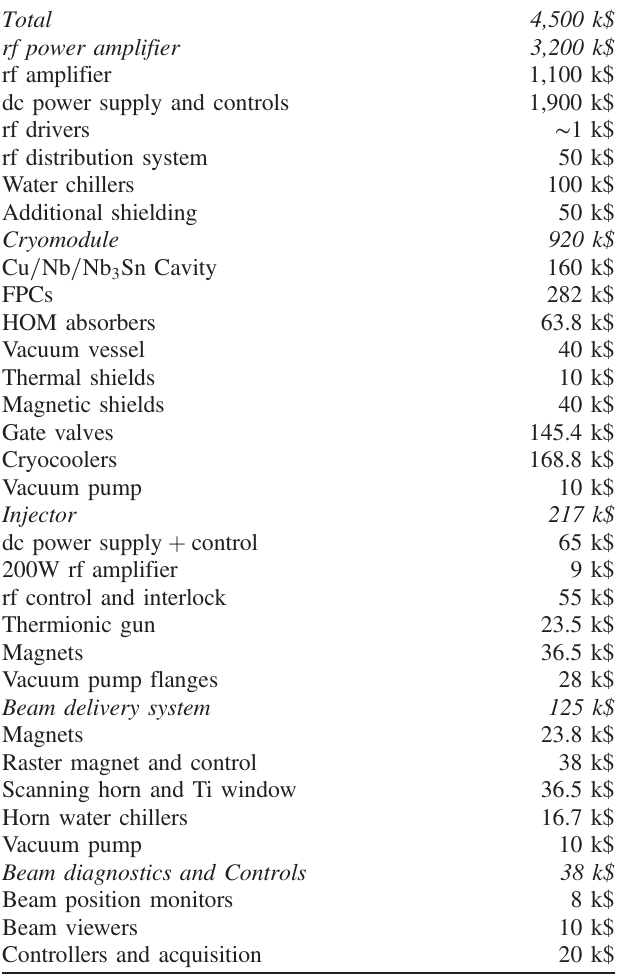
TABLE VI. Capital cost of SRF accelerator components.